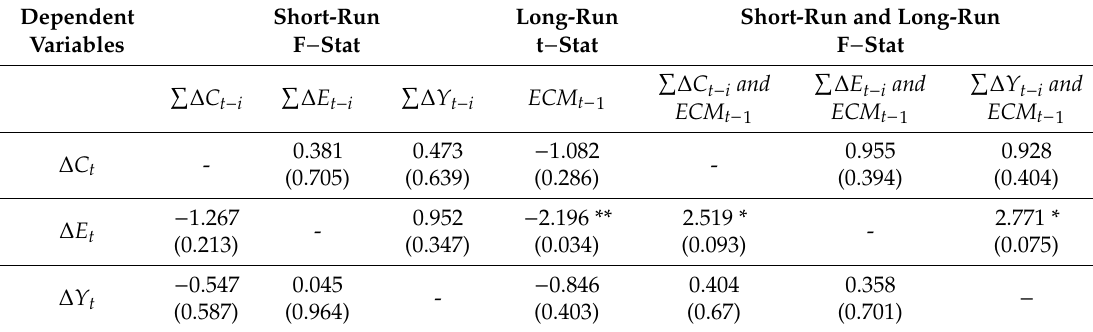
Table 7. Causality results (Malaysia).